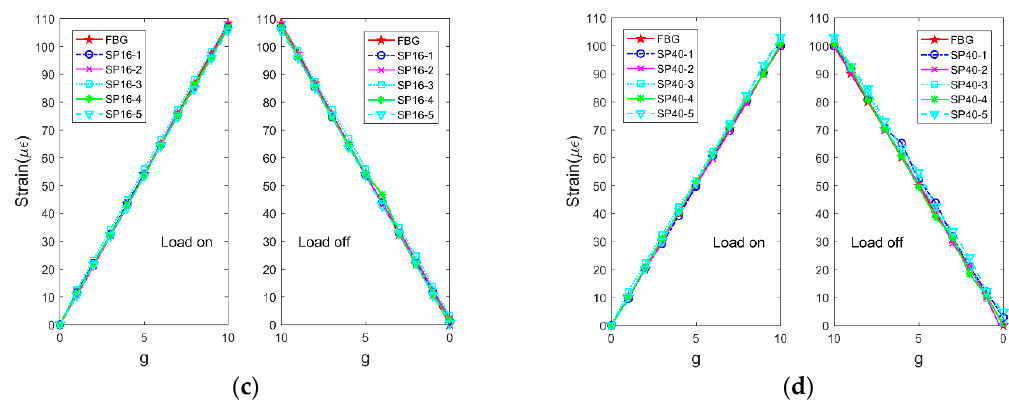
Figure 8. Strain data as measured by fiber Bragg grating (FBG) and smartphones with ( a ) 8, ( b ) 10, ( c ) 16, and ( d ) 40 MP.